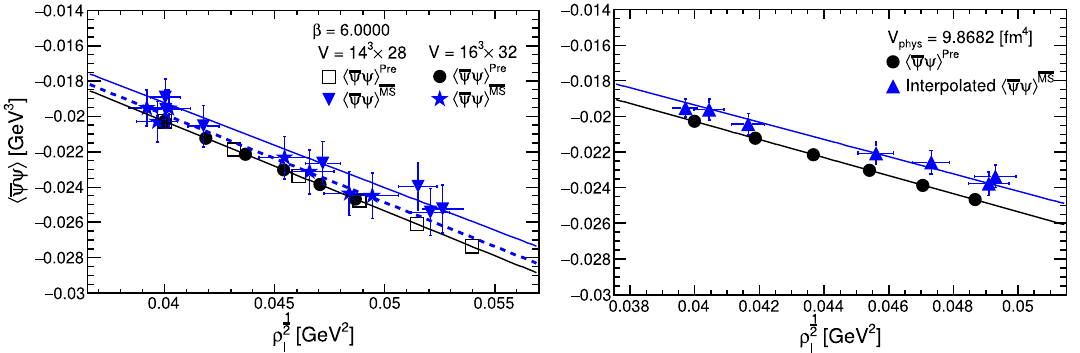
Fig. 15 Comparisons of the renormalized chiral condensate (cid:5) ¯ ψψ (cid:6) MS in the MS-scheme at 2 [GeV] of the configurations of β = 6 . 0000, V = 14 3 × 28 and V = 16 3 × 32 (left) and the interpolated results at the continuum limit (right) with the predictions (cid:5) ¯ ψψ (cid:6) Pre . In the left figure, the black full, the blue full, and the blue dashed lines indicate the